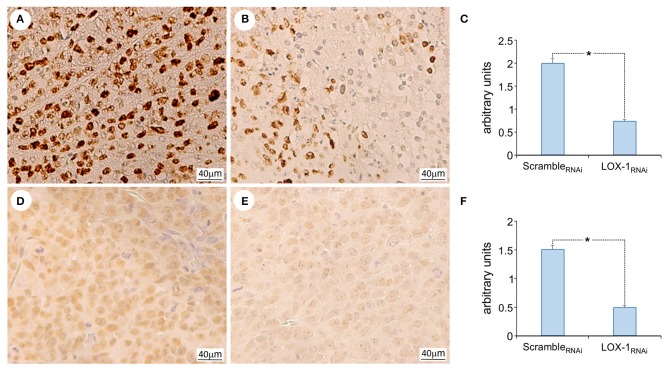
Representative images of the immunohistochemical analysis of Ki 67 and acetyl histone H4 expression. Ki 67 expression in scrambleRNAi
(A) and LOX-1RNAi
(B) xenograft tumors, and acetyl histone H4 in scrambleRNAi
(D) and LOX-1RNAi
(E) xenograft tumors. Scale bar 40 μm. Graphs show the significant decrease of Ki 67 expression (C) and acetyl histone H4 expression (F) in LOX-1RNAi respect to scrambleRNAi tumors (*P < 0.01).